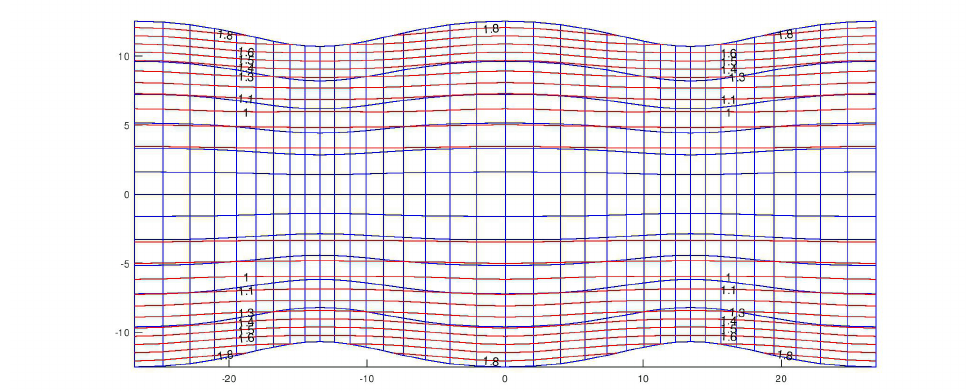
Fig. 9. The cartographic grid and the distribution of distortions obtained in the normal cylindrical projection created with the Bugayevskiy method with a scale coefficient of 0.7